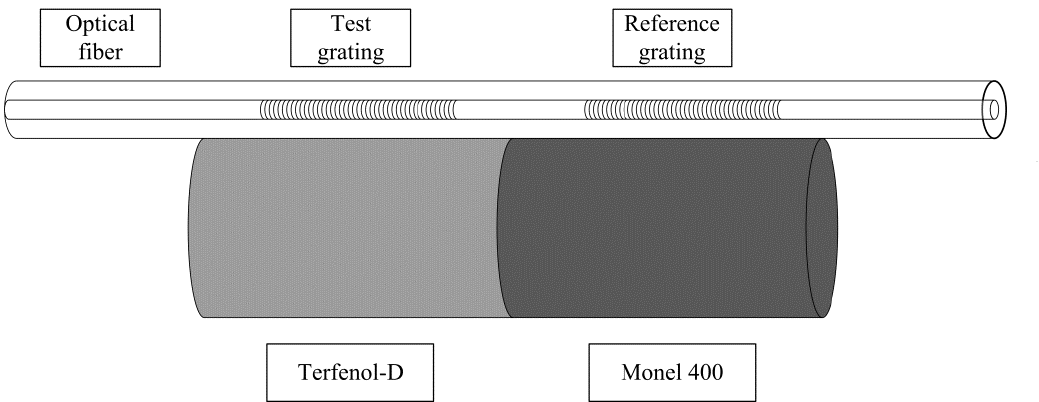
Figure 14. Schematic diagram of the fiber sensor proposed by Mora et al .